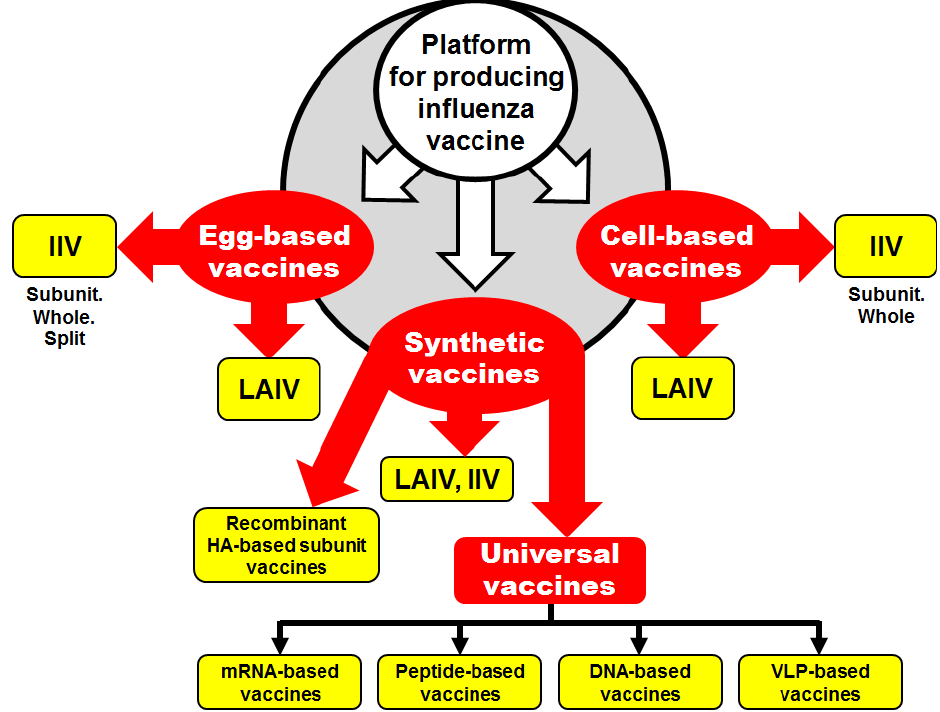
Figure 1. Conventional and novel platforms for influenza vaccine production.